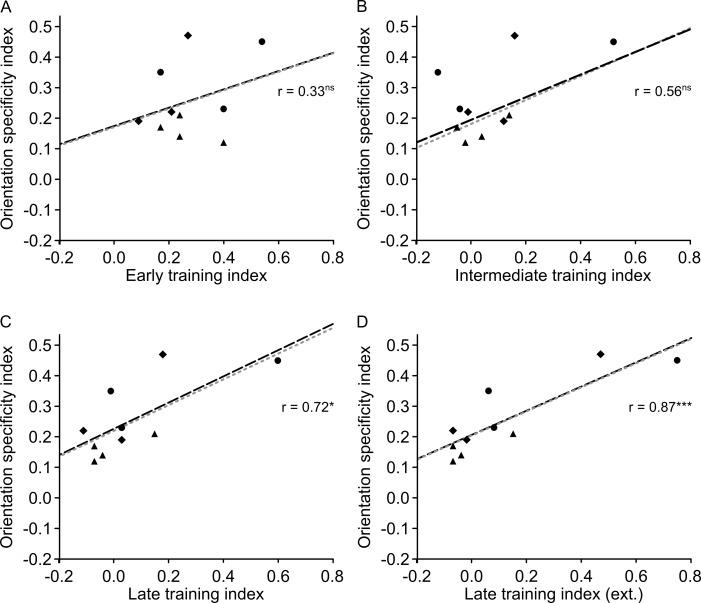
Scatterplot of orientation specificity and early (A), intermediate (B), and late training indices either based on 60 thresholds learning data (C) or on the same data including additional asymptotic data for participants P2-4 and P8-10 (D). The black dashed line results from an ordinary least square regression, whereas the grey dotted line was fitted with betas obtained by using robust regression. Different symbols represent different training schemes: triangle = 15 sessions with 4 staircases, circle = 10 sessions with 8staircases, diamond = 15 sessions with 4 staircases plus 3 refresher sessions. * p < .050, ** p < .010, *** p < .005.